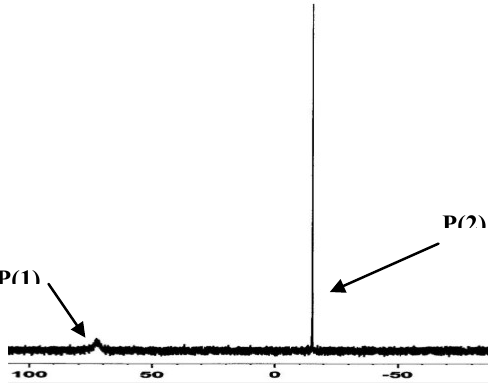
Figure 2. 31 P NMR spectrum of Na